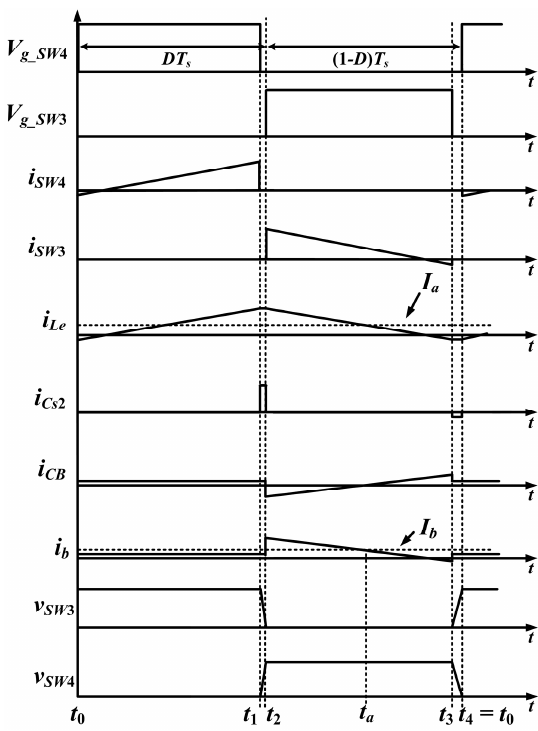
Figure 6. Voltage and current waveforms of the proposed converter for boost forward-conversion.